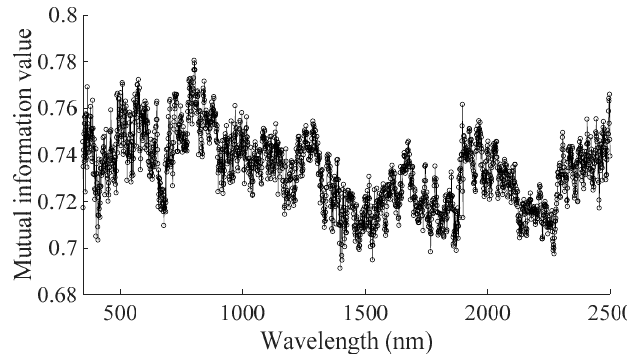
Figure 4. Mutual information ( MI) between TSS and feature of each wavelength.